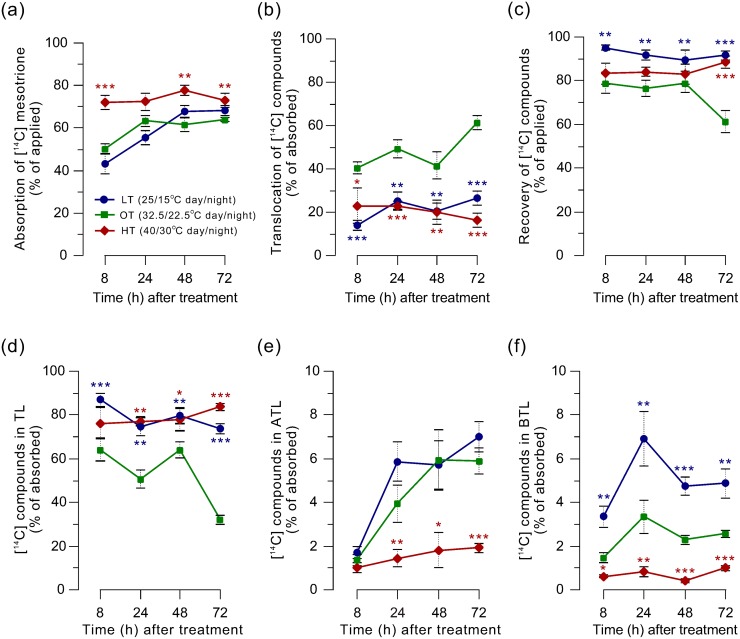
[14C] mesotrione absorption (a), translocation (b), total recovery (c), and translocation to treated-leaf (d), above treated-leaf (e) and below treated-leaf (f) at three different temperatures (low temperature, LT, 25/15°C; optimum temperature, OT, 32.5/22.5°C; and high temperature, HT, 40/30°C; 15/9 h day/night).The upper surface of fourth youngest leaf of Palmer amaranth plants (10 to 12 cm tall, 8 to 10 leaf stage) were treated with 4- x 2.5-μL droplets (1.6548 mM mesotrione, 0.85% w/v AMS, and 1% COC) containing 3.3 kBq of [14C] mesotrione. Significant differences (within harvest time) between the OT and LT (blue asterisks) or HT (red asterisks) plants are indicated with asterisks (*, P ≤ 0.05; **, P < 0.01). Error bars represent SE.